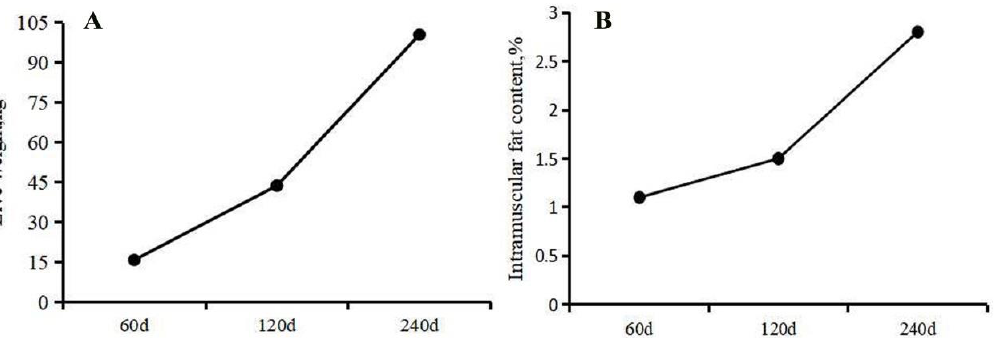
Figure 1. Phenotypic characteristics in the LD muscle of WH pigs. ( A ) Live weight. ( B ) IMF content of LD muscle over the three development stages.